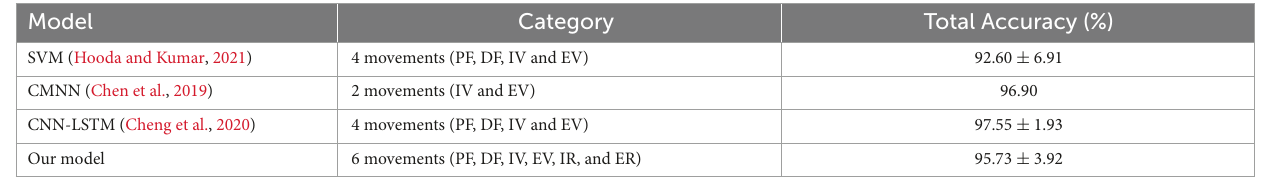
TABLE 7 Comparison with the state-of-the-art method.